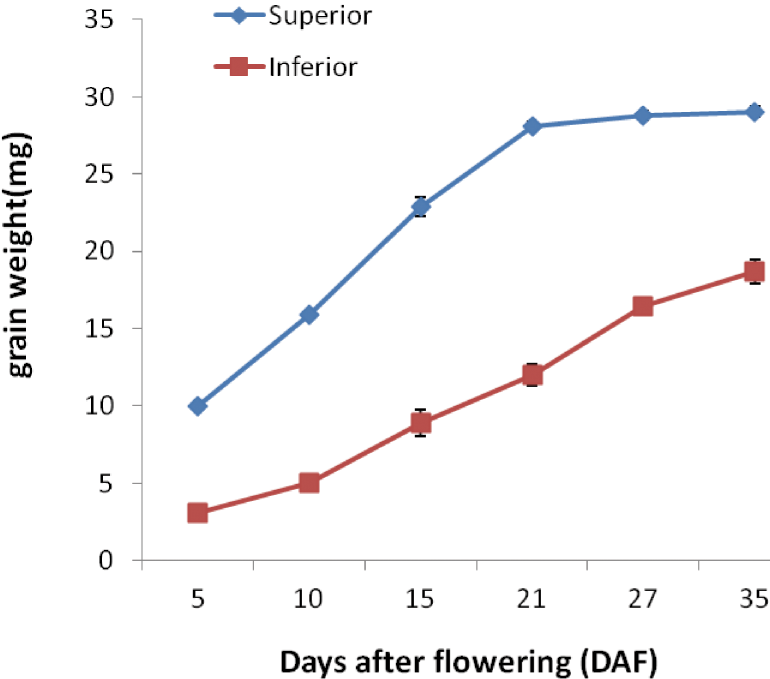
Fig 1. Grain weight of superior and inferior grains on the rice panicle. Grains were sampled at 5, 10, 15,21,27,35 days after fertilization, and the average dry weight of grains was measured.